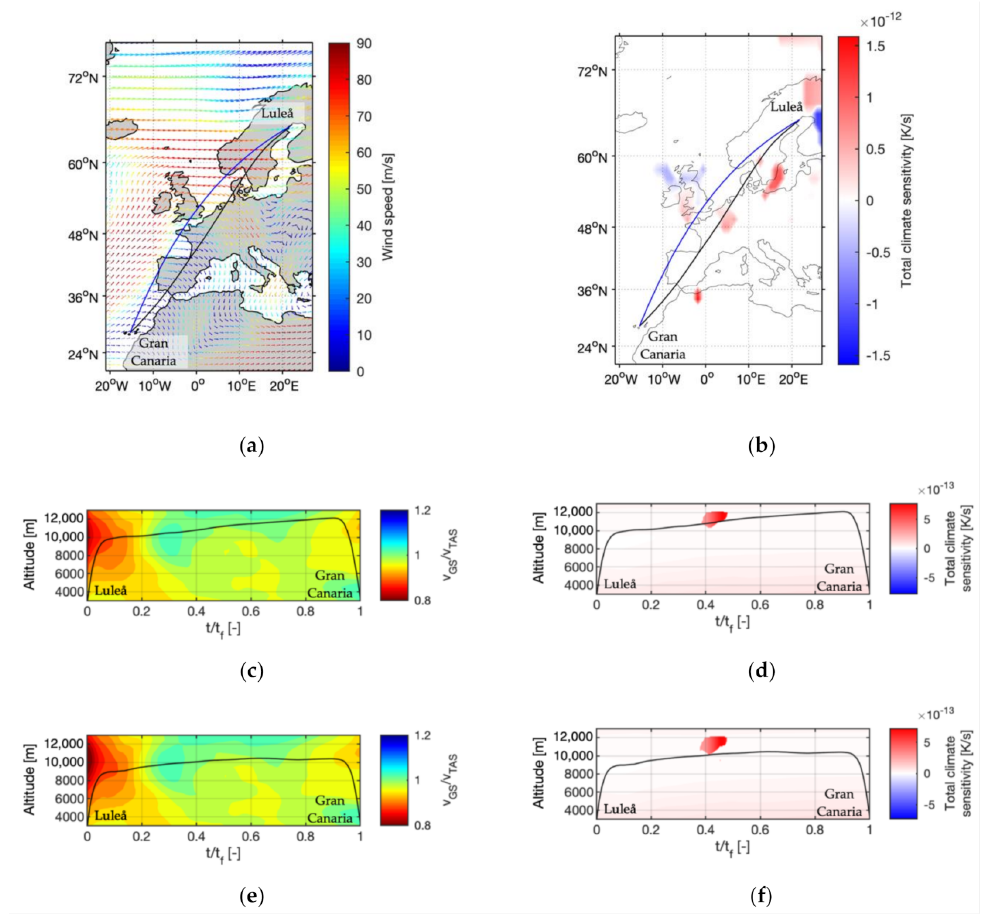
Figure 5. Optimized trajectories for the route Luleå-Gran Canaria. The lateral path of the minimum fuel trajectory (black) is illustrated including the wind situation ( a ) and the total climate sensitivity ( b ) at an average altitude of 10,686 m. The orthodrome is depicted in blue. The lateral path of the minimum climate impact trajectory is not shown separately, since only minor deviations from the minimum fuel trajectory occur. Altitude profiles along the cross section of the lateral path are shown for the minimum fuel case ( c ), ( d ) and the minimum climate impact case ( e ), ( f ) as a function of the relative flight time t/t f . The wind situation for the vertical trajectories is indicated as ratio between ground speed v GS and true airspeed v TAS . Values greater than one indicate tailwind areas, values smaller than one indicate headwind